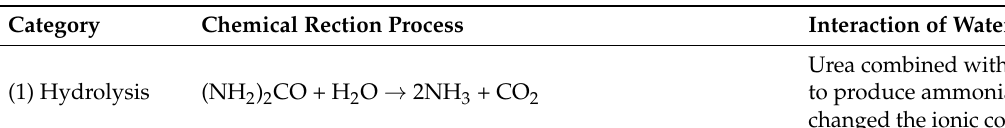
Table 5. Mechanism reaction of urea in drip